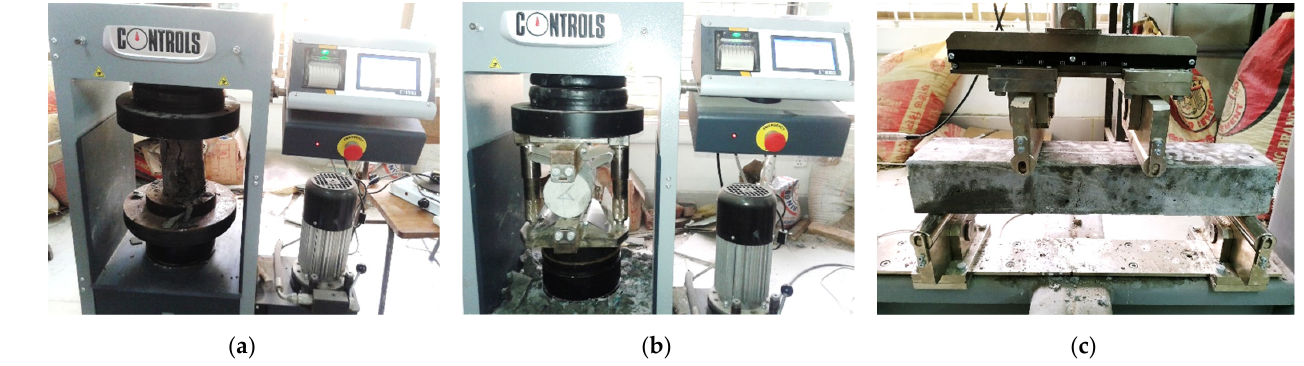
Figure 5. Experimental setup of the hardened concrete test, ( a ) compressive strength test, ( b ) splitting tensile strength test, ( c ) flexural strength test.